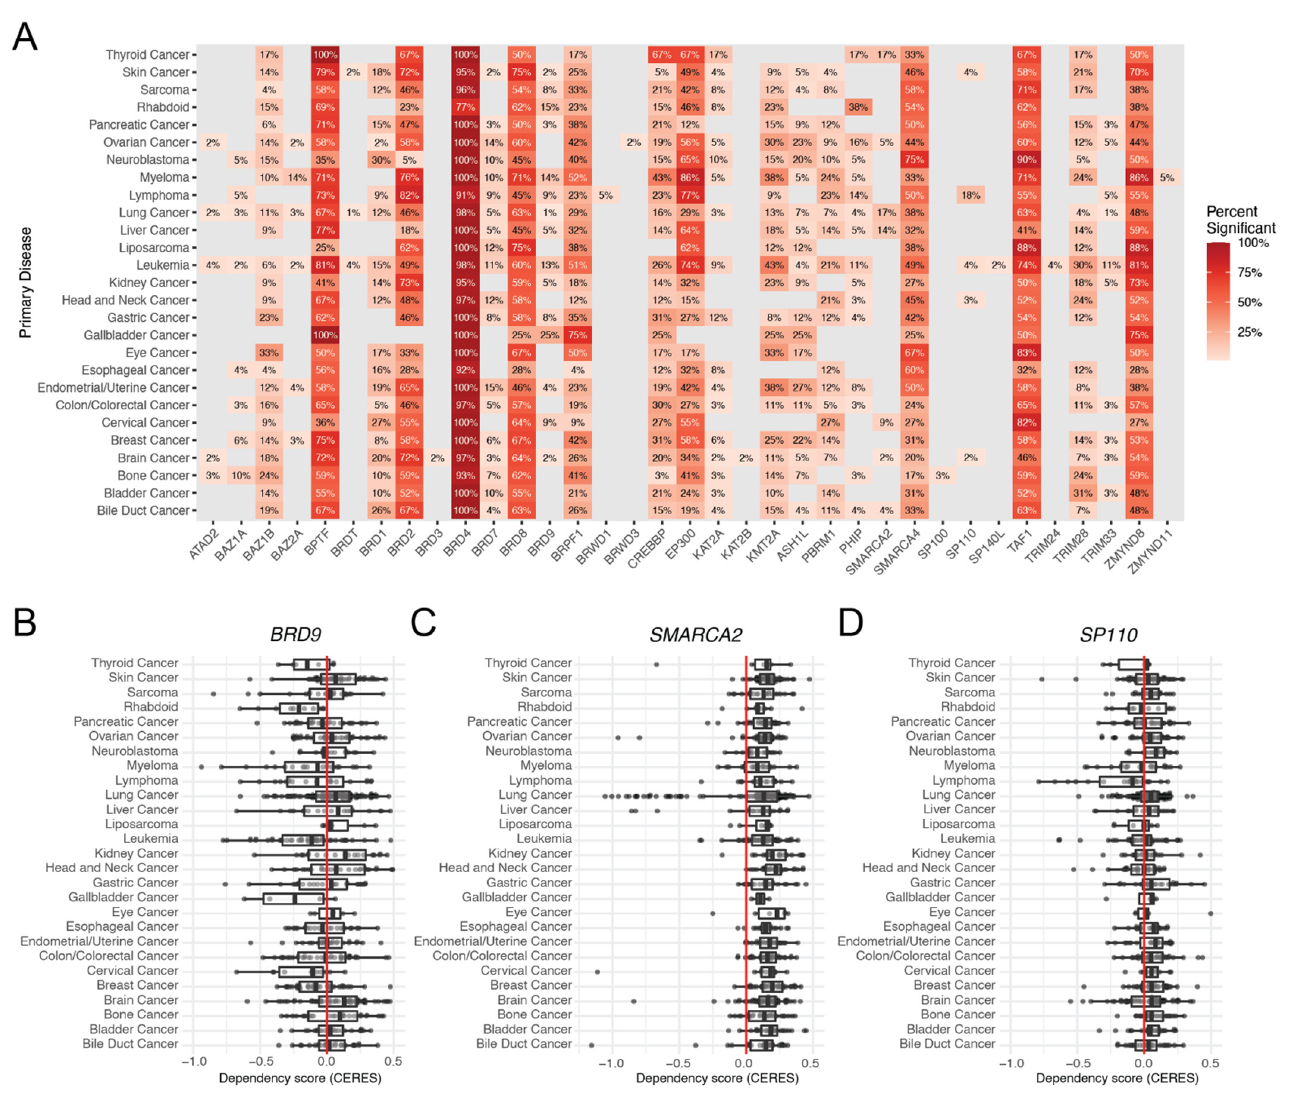
Figure 3. Dependency of bromodomain genes in systematic CRISPR knockout screens from the Cancer Dependency Map project (https://depmap.org/portal/depmap, accessed on 7 July 2021). The CERES score indicates the likelihood that a gene is essential [84]. A CERES score of 0 means the gene is not essential, while − 1 is comparable to the median of all pan-essential genes. Data were retrieved from depmap.org (release 21Q1). ( A ) The percentage of cancer cell lines with CERES scores < − 0.5 for each BRD gene across disease types. CERES scores for ( B ) BRD9, ( C ) SMARCA2, and ( D ) SP110 across disease types.